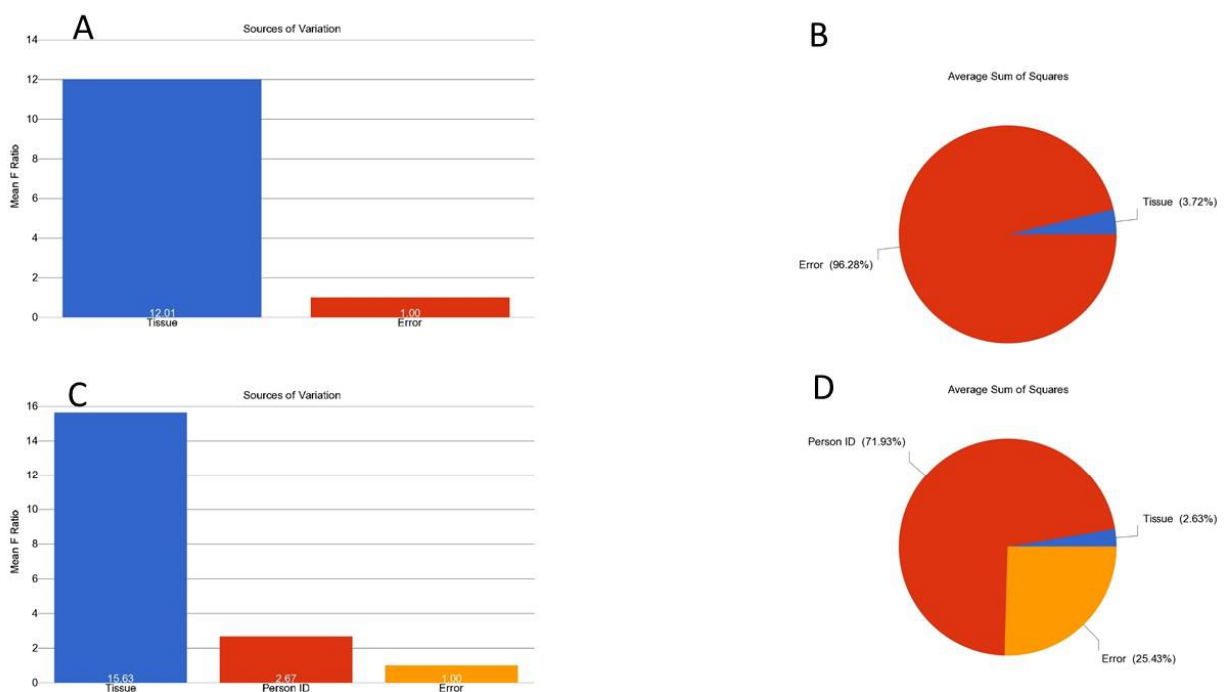
Figure 1. Variation of RTL in the data. The source of variations in the RTL that can be explained in the ANOVA models are shown. The upper row ( A , B ) shows unpaired analysis, and the lower row ( C , D ) shows result from paired analysis (taking the “Person ID” in the ANOVA model). The mean F-ratio (F-statistics for the factor/F-statistics for the model error) representing the significance of the factor in the ANOVA model is shown in the bar graphs ( A , C ). The sums of squares in the ANOVA model representing the proportion of the variation explained by the factors are shown as pie charts ( B , D ). When the “Person ID” is not included in the ANOVA model (unpaired analysis shown in ( B )), 96% of the variation in RTL cannot be explained (error, 96.28). However, when the “Person ID” is incorporated into the ANOVA model (paired analysis shown in ( D )), the error reduces to 25%, and the person-to-person variation explains 71.93% of the variation in RTL. Table 2. RTL in CRC and paired normal